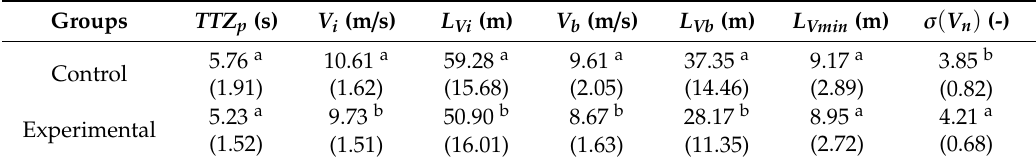
Table 3. Mean value (standard deviation) of the speed profile variables across groups. Legend : TTZ d is the time left for the vehicle to reach the crosswalk; V i and L Vi are speed and associated distance from the crosswalk when the driver released the accelerator pedal; V b and L Vb are speed and associated distance from the crosswalk when the driver applied the brakes; L Vmin is the distance from the crosswalk at which the minimum speed was observed; σ ( V n ) is the standard deviation of vehicle speeds.